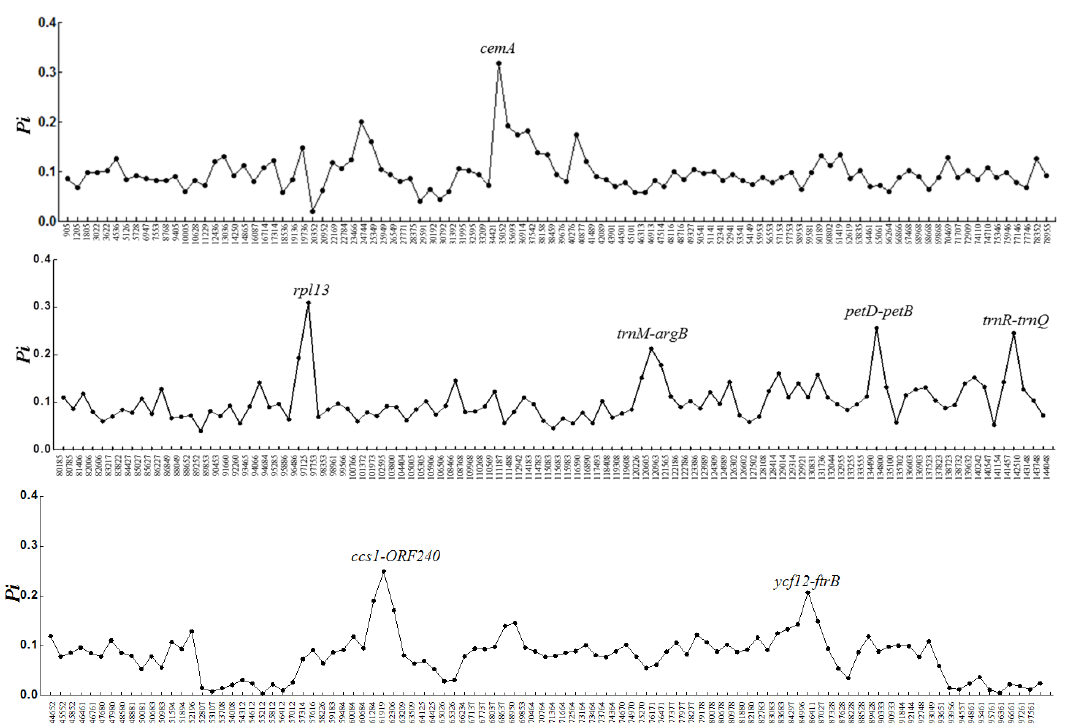
Figure 2. Sliding window analysis of the whole chloroplast genomes of seven Pyropia species. Window length: 600 bp; step size: 250 bp. X-axis: position of the midpoint of a window; Y-axis: nucleotide diversity of each window ( Pi ).